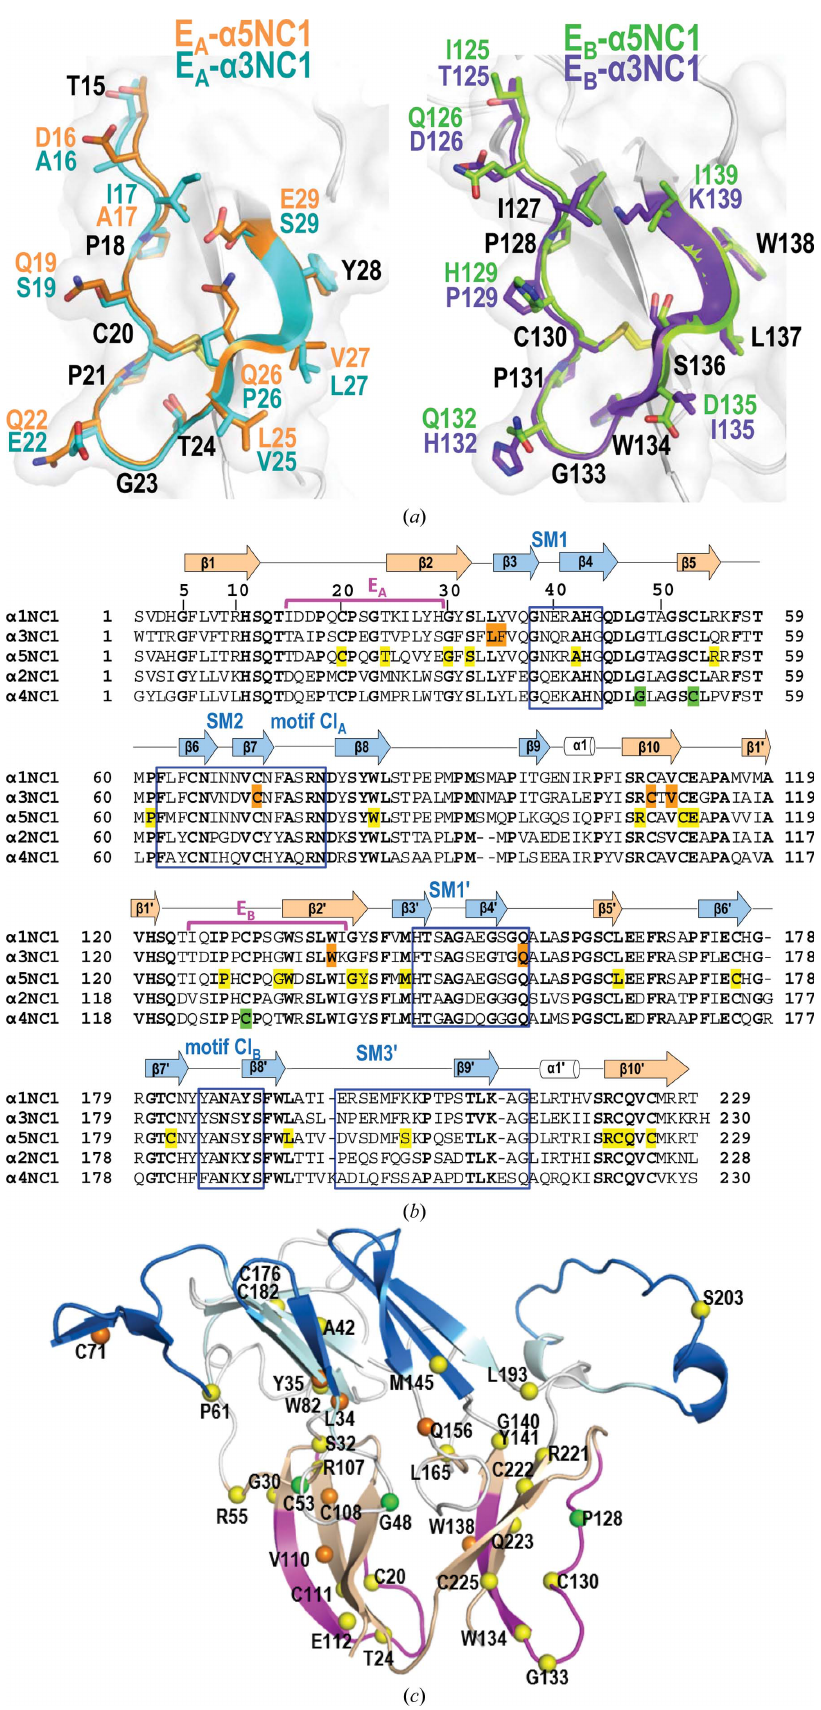
Figure 5 Structural bases of Alport’s and Goodpasture’s syndromes. ( a ) Goodpasture’s epitopes E A (left) and E B (right) as seen in the superimposed structures of subunits of (cid:2) 3NC1 homo (cyan or blue) and (cid:2) 5NC1 homo (orange or green). The same colour code is used for the amino-acid side chains (except for invariant residues, which are shown in black). ( b ) Structure-assisted sequence alignment of the (cid:2) 1– 5NC1 chains. Arrows indicate (cid:3) -strands and cylin- ders indicate (cid:2) -helices. (cid:3) -Strands of the I/I 0 and II/ II 0 sheets are coloured light pink and light blue, respectively. Blue rectangles enclose flexible regions and Cl motifs (labelled), horizontal magenta lines mark the E A and E B epitopes (also labelled) and coloured shadowing indicates the residues reported to host missense mutations in Alport’s syndrome. ( c ) Alport’s syndrome missense mutations (listed in Supplementary Table S5) are mapped onto the structure of an (cid:2) 5NC1 subunit. Yellow spheres represent mutations in this chain, while super- imposed mutations of (cid:2) 3NC1 and (cid:2) 4NC1 are coloured orange and green. (cid:3) -Sheets I/I 0 and II/II 0 are coloured light pink and light blue, respectively, E A and E B are shown in magenta and flexible SM regions and Cl motifs are presented in deep